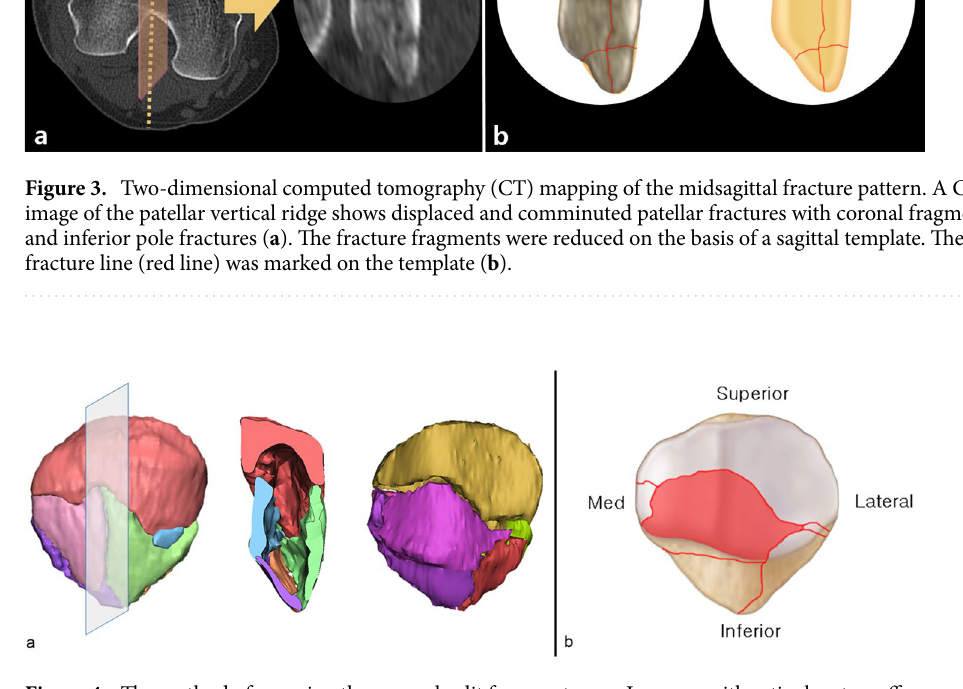
Figure 4. The method of mapping the coronal split fragment zone. In a case with articular step-off presented after the anterior cortex was perfectly reduced, the coronal split fragment was identified in a midsagittal cut and articular surface imaging ( a ). The zone of the coronal split fragment was marked on the coronal articular surface template ( b